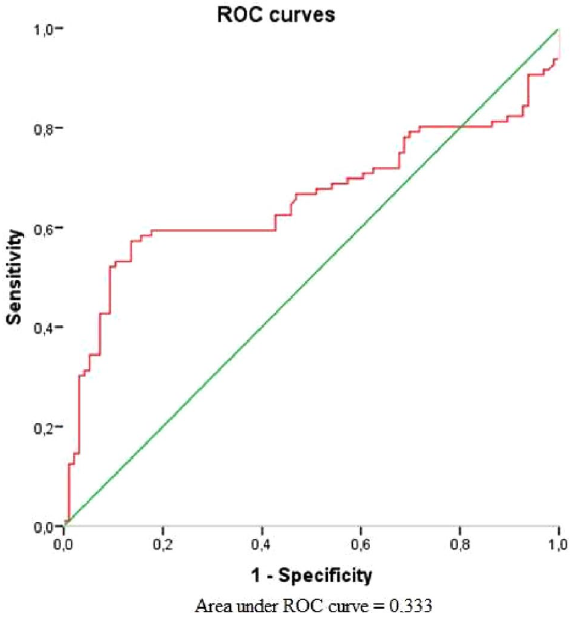
Figure 2. Receiver operating curve graph to evaluate the diagnostic performance of serum CRH for forecasting of vitiligo